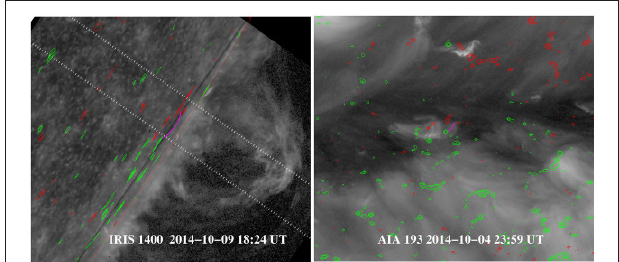
FIGURE 11 | Left: IRIS Si IV 1400 Å rotated to its orientation on the limb taken at 18:24 UT on 9 October 2014. The white dashed lines indicate the region of reduced emission in the Si IV 1394 Å spectra shown in Figure 10 . The green (negative) and red (positive) contours are the LOS photospheric magnetic field taken by SDO/HMI. The purple line crosses the PIL for this region. Right: AIA 193 Å with HMI magnetic field contours with the PIL at 23:59 UT on 4 October 2014.